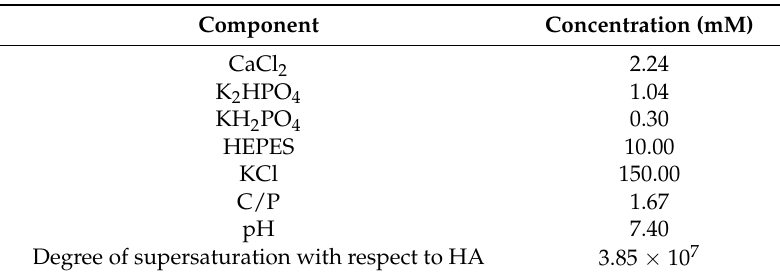
Table 1. Composition of the mineralizing solution.